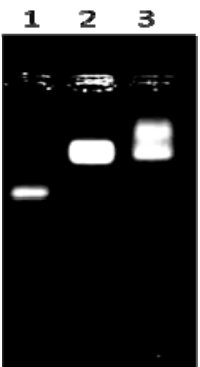
Figure 2. Electropherograms of QDs-IgG complexes in agarose gel. Line 1, QDs alone; Line 2, QDs-Protein A; Line 3,